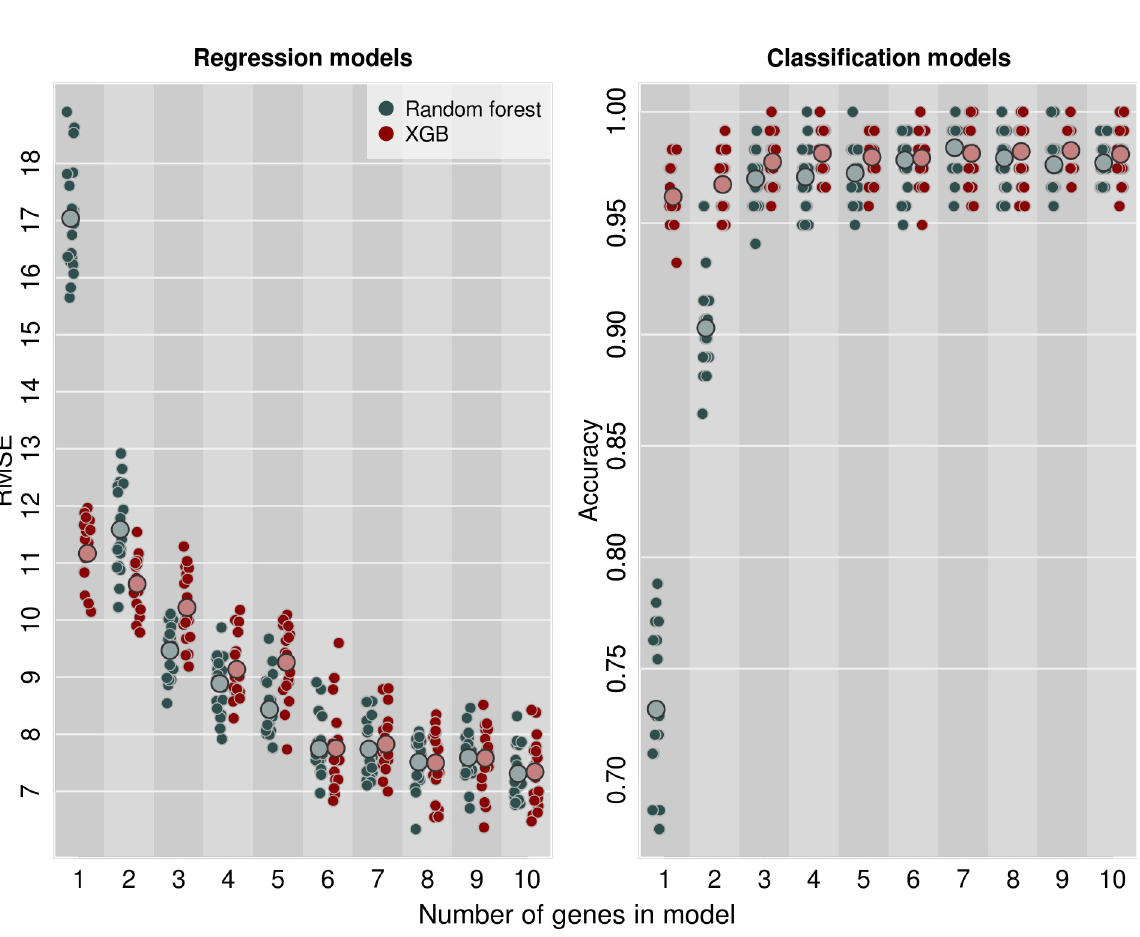
Fig 6. Predictive power of XGB and random forest models plateaus after the top 6 genes are included in the models (left). Accuracy of classification models plateaus after top 3 genes are included, with > 95% accuracy achievable with only two genes (right). Small points show models run on independent test-train splits of the data (20 replicates per gene number); large points show the mean for each category. Points are jittered on the x axis to show overlapping data.